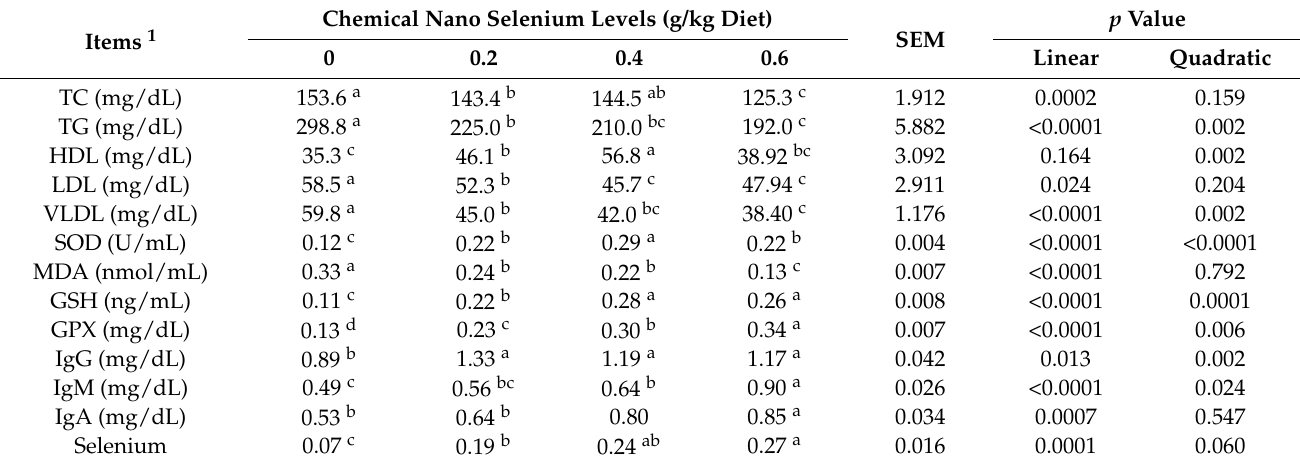
Table 8. Lipid profile of growing Japanese quail as affected by dietary